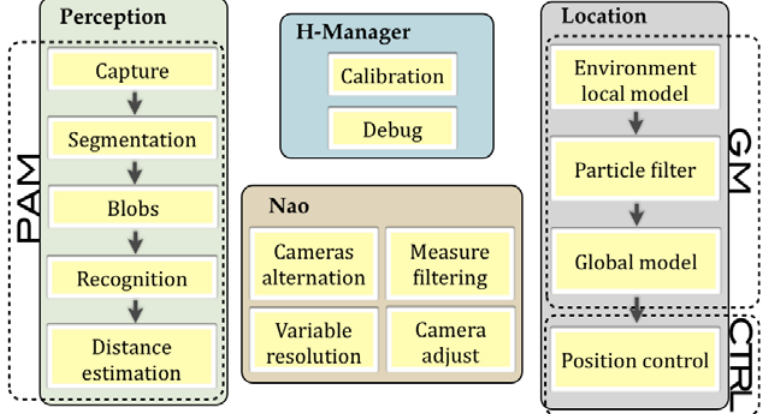
Figure 2. Diagram with the SW routines involved in location and